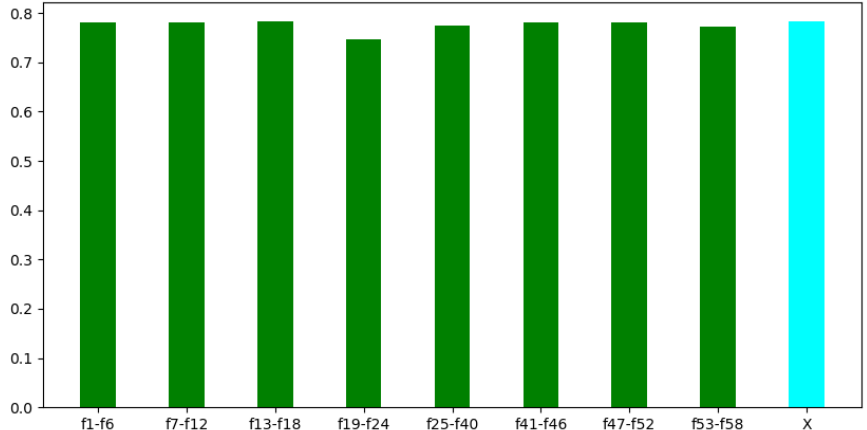
Figure 10. Performance of FLG-VQA in cases in which a part of the video-level feature vector was eliminated. The performance of the whole feature vector is denoted by ‘X’. The median SROCC values were measured on KoNViD-1k [16] over 1000 random training–testing splits. Table 1 gives information about the interpretation of feature